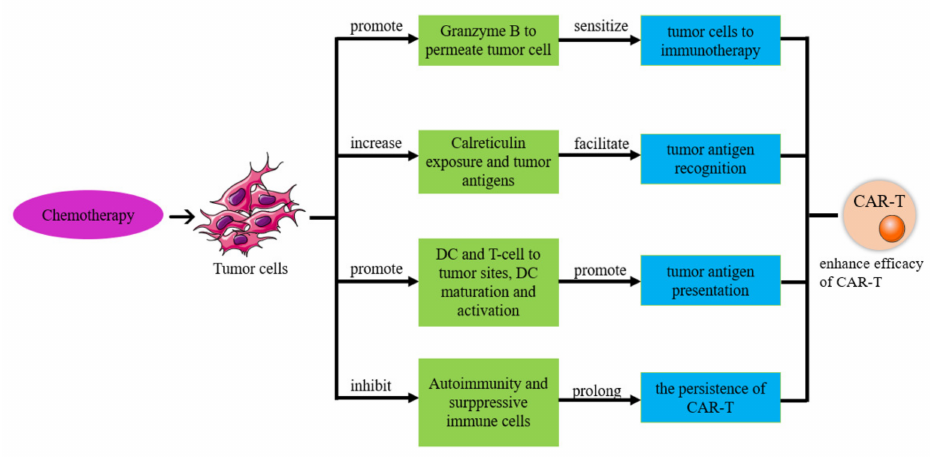
Figure 8. Mechanism of chemotherapy to improve the effect of CAR-T